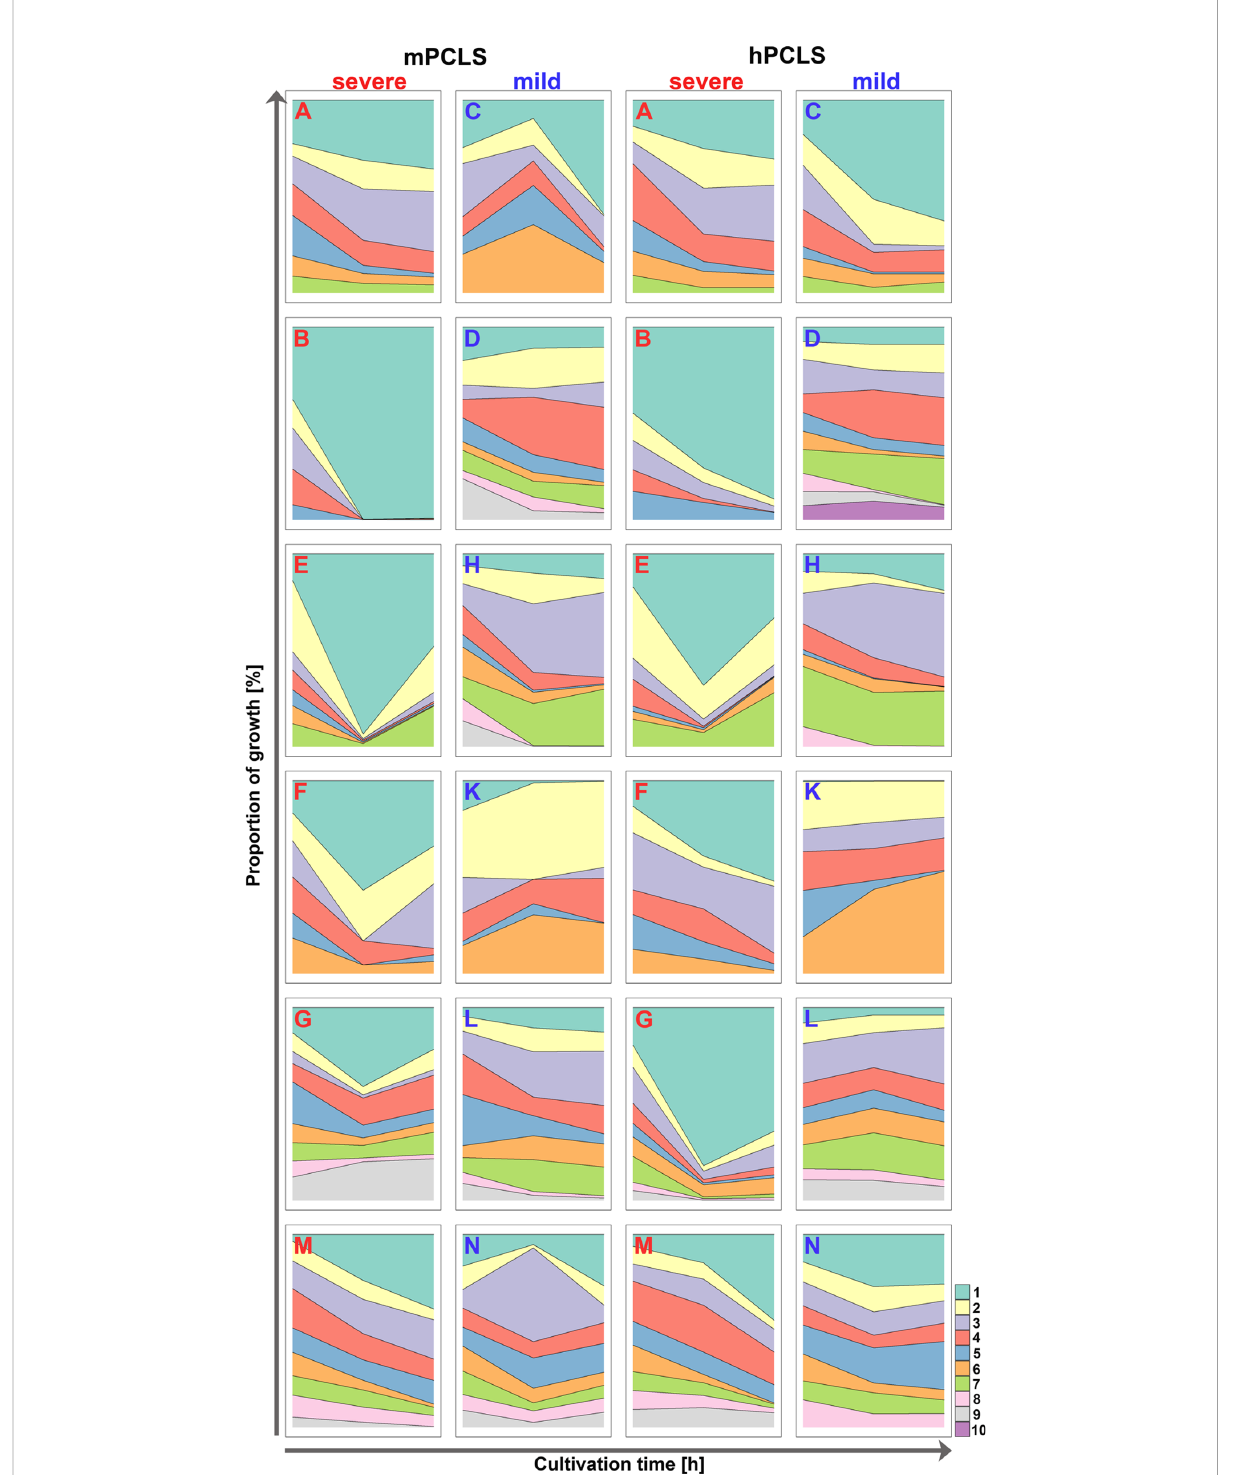
FIGURE 3 Relative proportions of serial isolates during competitive growth in murine (left) and human PCLS (right) after 4 hours and 8 hours. For each serial isolate of the twelve longitudinal courses, its fraction in the clonal community at the time points 0 h, 4 h and 8 h is shown. Longitudinal courses are differentiated by a bold letter (severe courses in red; mild courses in blue). Each serial isolate is depicted by color sorted by increasing colonization time of the clone in the patient ’ s lungs. For more detailed information see Supplementary Dataset S1. For outcome of the second biological replicate see Supplementary Figure